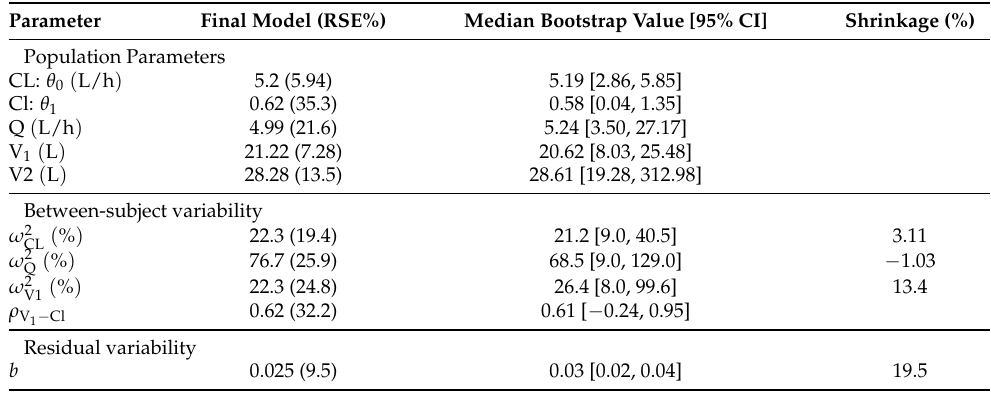
Figure 2. Observed plasma concentration vs Time After Last Dose profile for vancomycin. Table 2. Estimated parameters for the final VAN